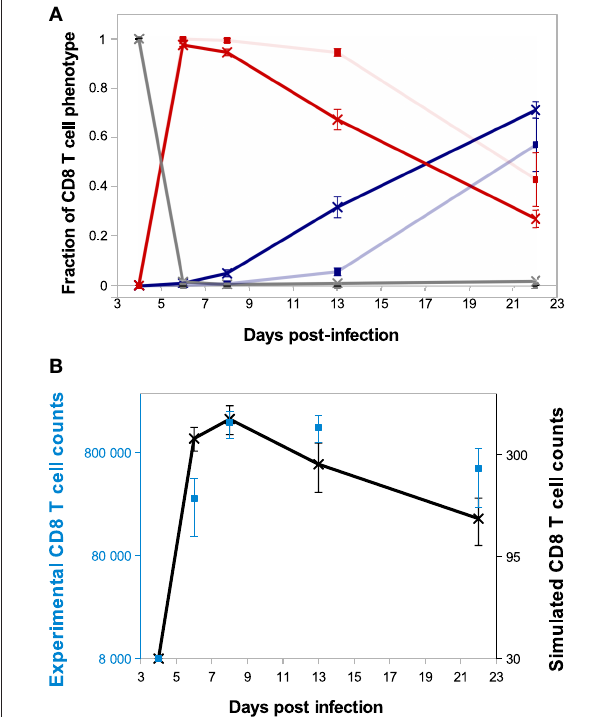
FIGURE 3 | CD8 T-cell population dynamics. (A) Fraction of each cell type among the CD8 T-cell population. Gray: naive+pre-activated cells; red: activated+effector cells; blue: memory cells; full lines with crosses: in silico (mean ± standard deviation over 10 simulations); transparent lines with squares: in vivo (mean ± standard deviation over data from 5 mice). Error bars are most of time very small and then not visible. (B) Size of the CD8 T-cell population in silico (black crosses, right y-axis, mean ± standard deviation over 10 simulations) and in vivo (blue squares, left y-axis, mean ± standard deviation over data from 5 mice).